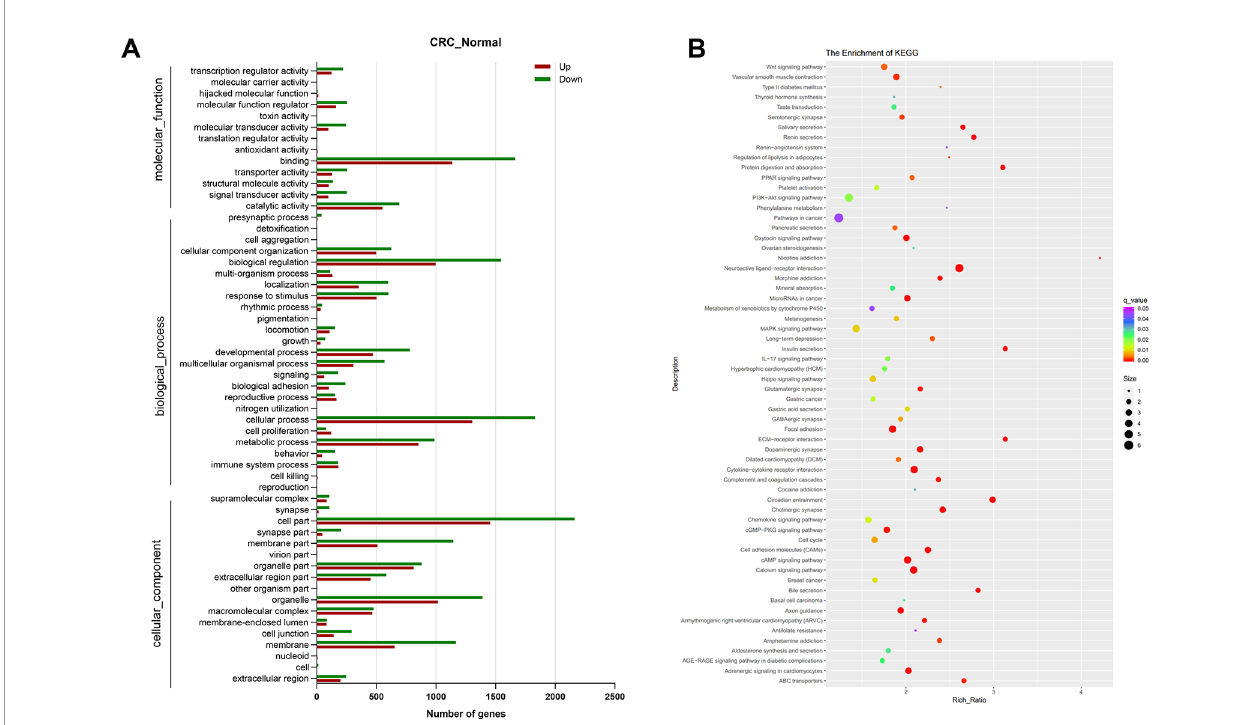
FIGURE 2 | Functional analysis of the differentially expressed genes. (A) Gene ontology (GO) enrichment and (B) Kyoto Encyclopedia of Genes and Genomes (KEGG) pathway enrichment analysis of differentially expressed genes between normal group and colorectal cancer (CRC) group. N =